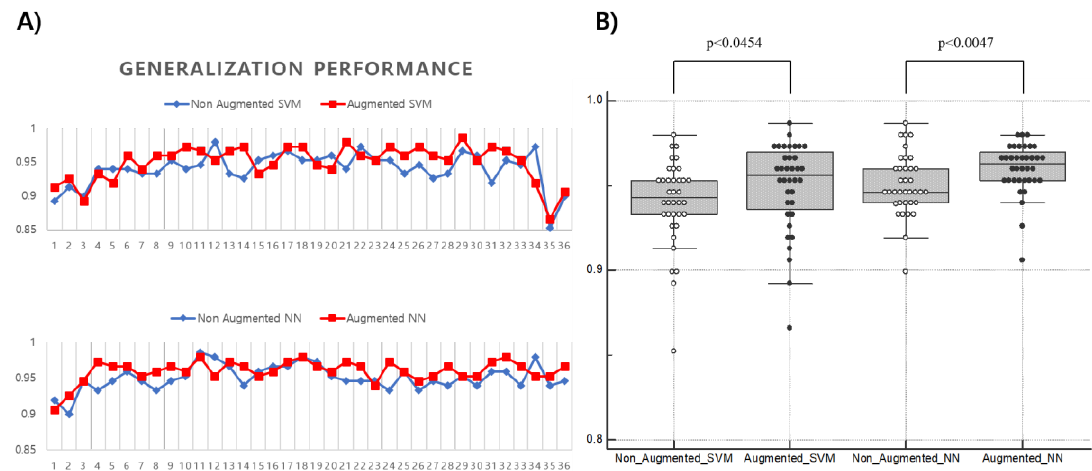
Figure 8. Comparison of the generalization performance of ML-based classifiers before and after GAN-based data augmentation. ( A ) Changes of generalization performance (y-axis) of support vector machine and neural network observed at each axial level (x-axis); ( B ) Difference in generalization performance (y-axis) of ML models before and after GAN-based data augmentation (x-axis). Each ML model for the axial level generally improved with statistical evidence after data augmentation.